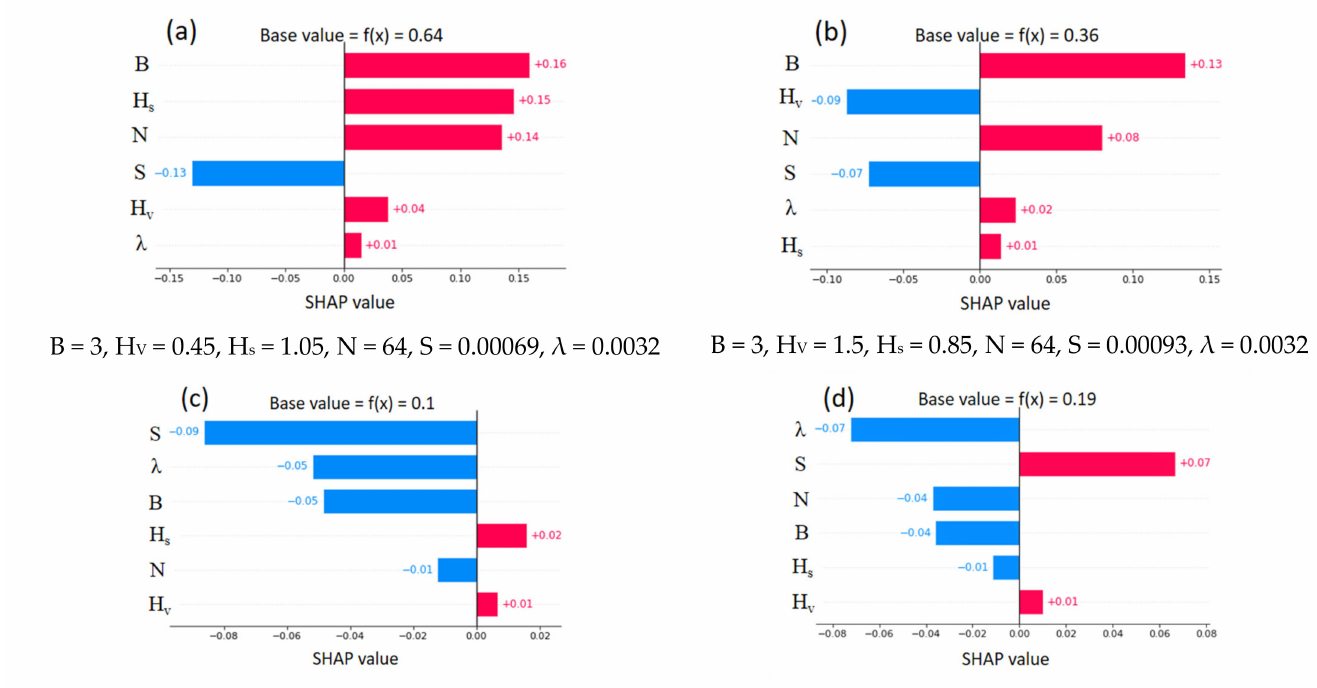
Figure 14. Instance-based SHAP explanations for U B (XGBoost